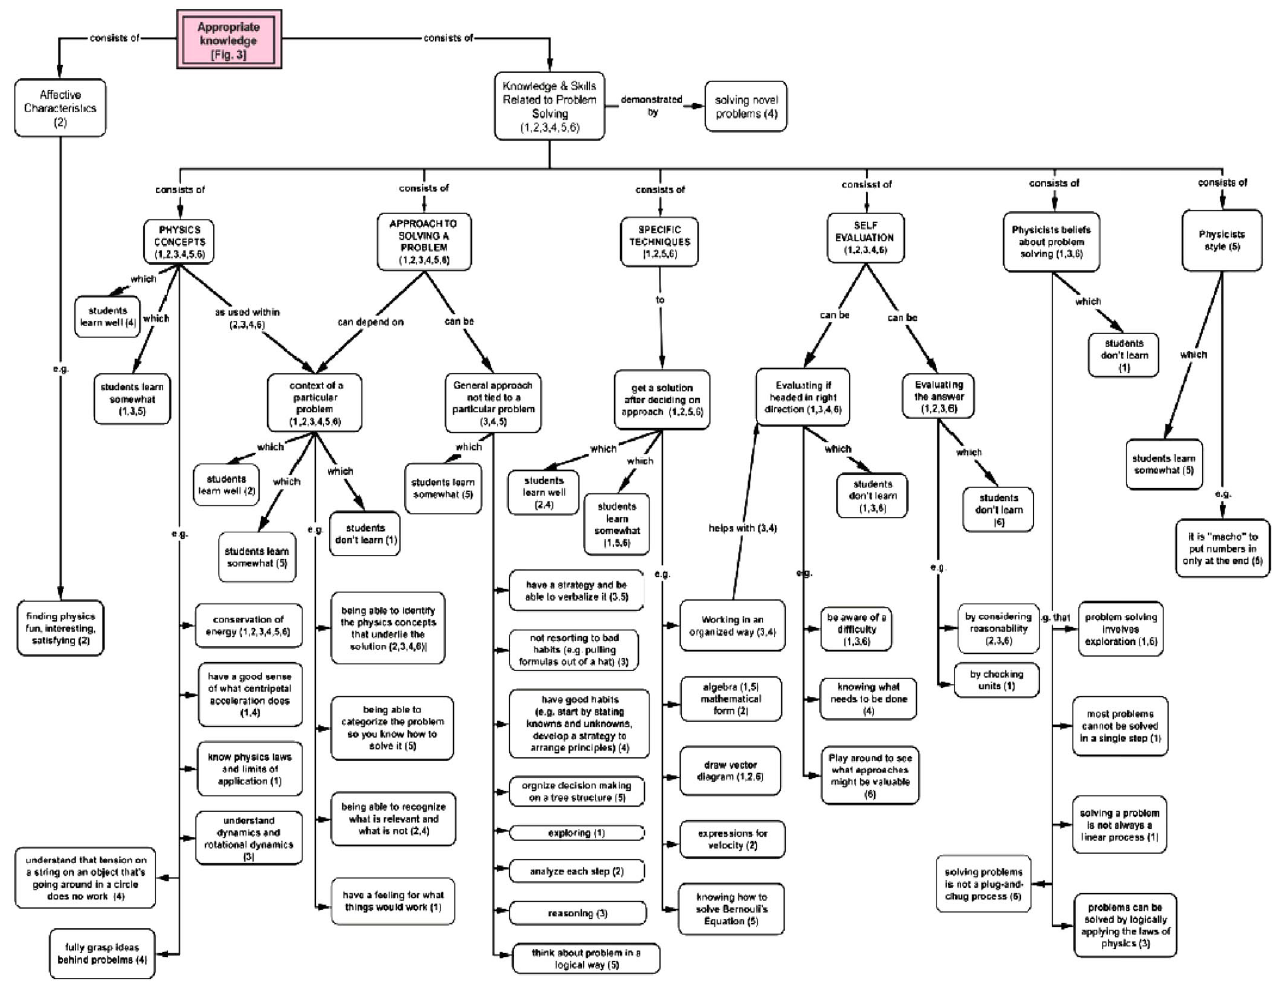
FIG. 3. (cid:1) Color (cid:2) “Appropriate Knowledge” composite map of faculty beliefs about problem-solving goals in an introductory physics course. Numbers in the parentheses denote the instructor whose statements directly justify that